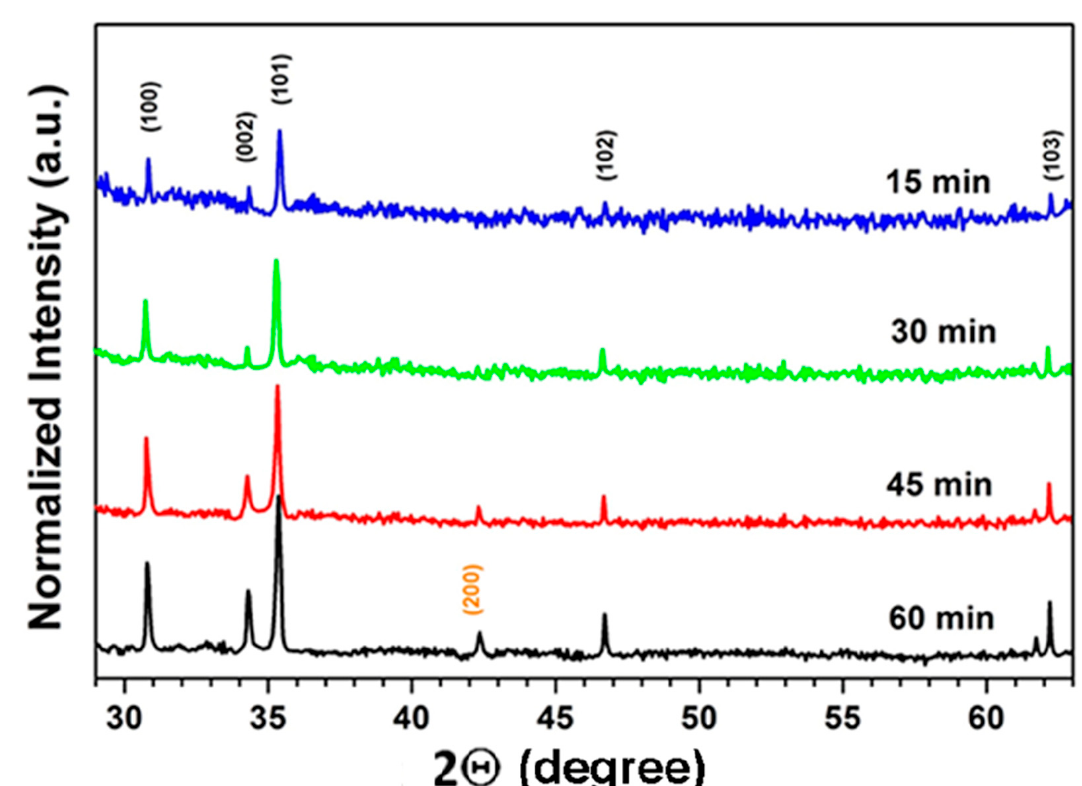
Figure 2. XRD pattern of Zn 0.5 Mg 0.5 O films deposited by spin coating and subjected to annealing in air at 500 °C for various durations.